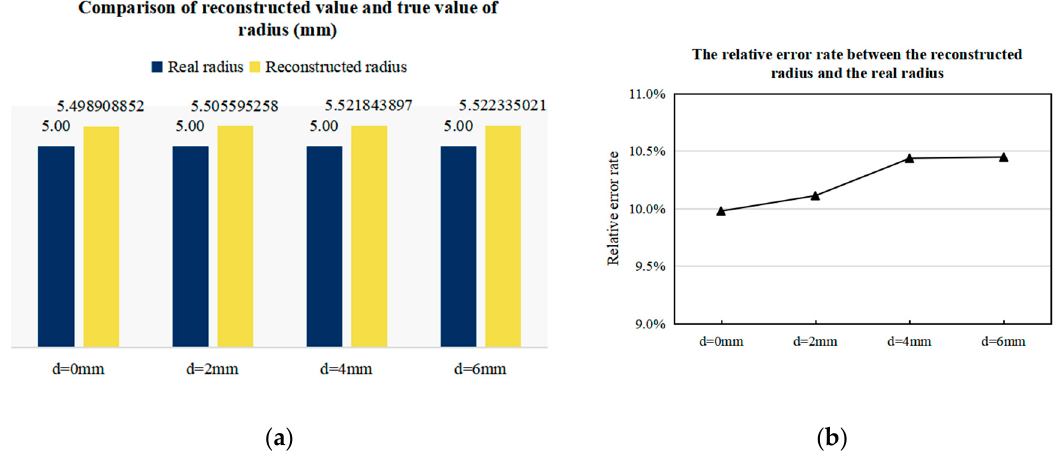
Figure 14. Error of reconstructed value and true value of artery radius with different d values. ( a ) The comparison of the reconstructed radius value with the true value. ( b ) The relative error between the reconstructed radius value and the true value.